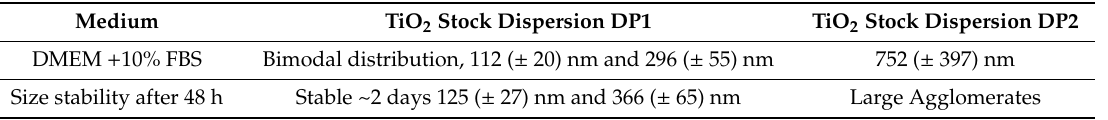
Table 2. Average hydrodynamic diameters determined, by Dynamic Light Scattering (DLS), of the obtained TiO 2 NPs stock dispersions